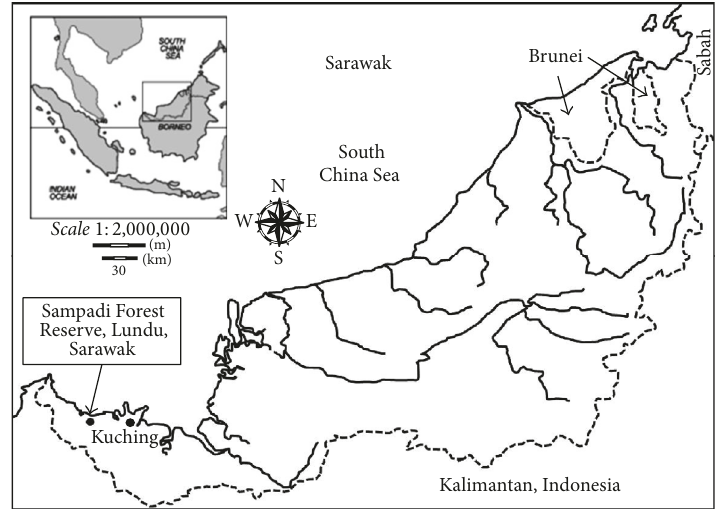
Figure 1: Location of the study area: Sampadi Forest Reserve, Lundu, Sarawak. Perumal et al. [18].